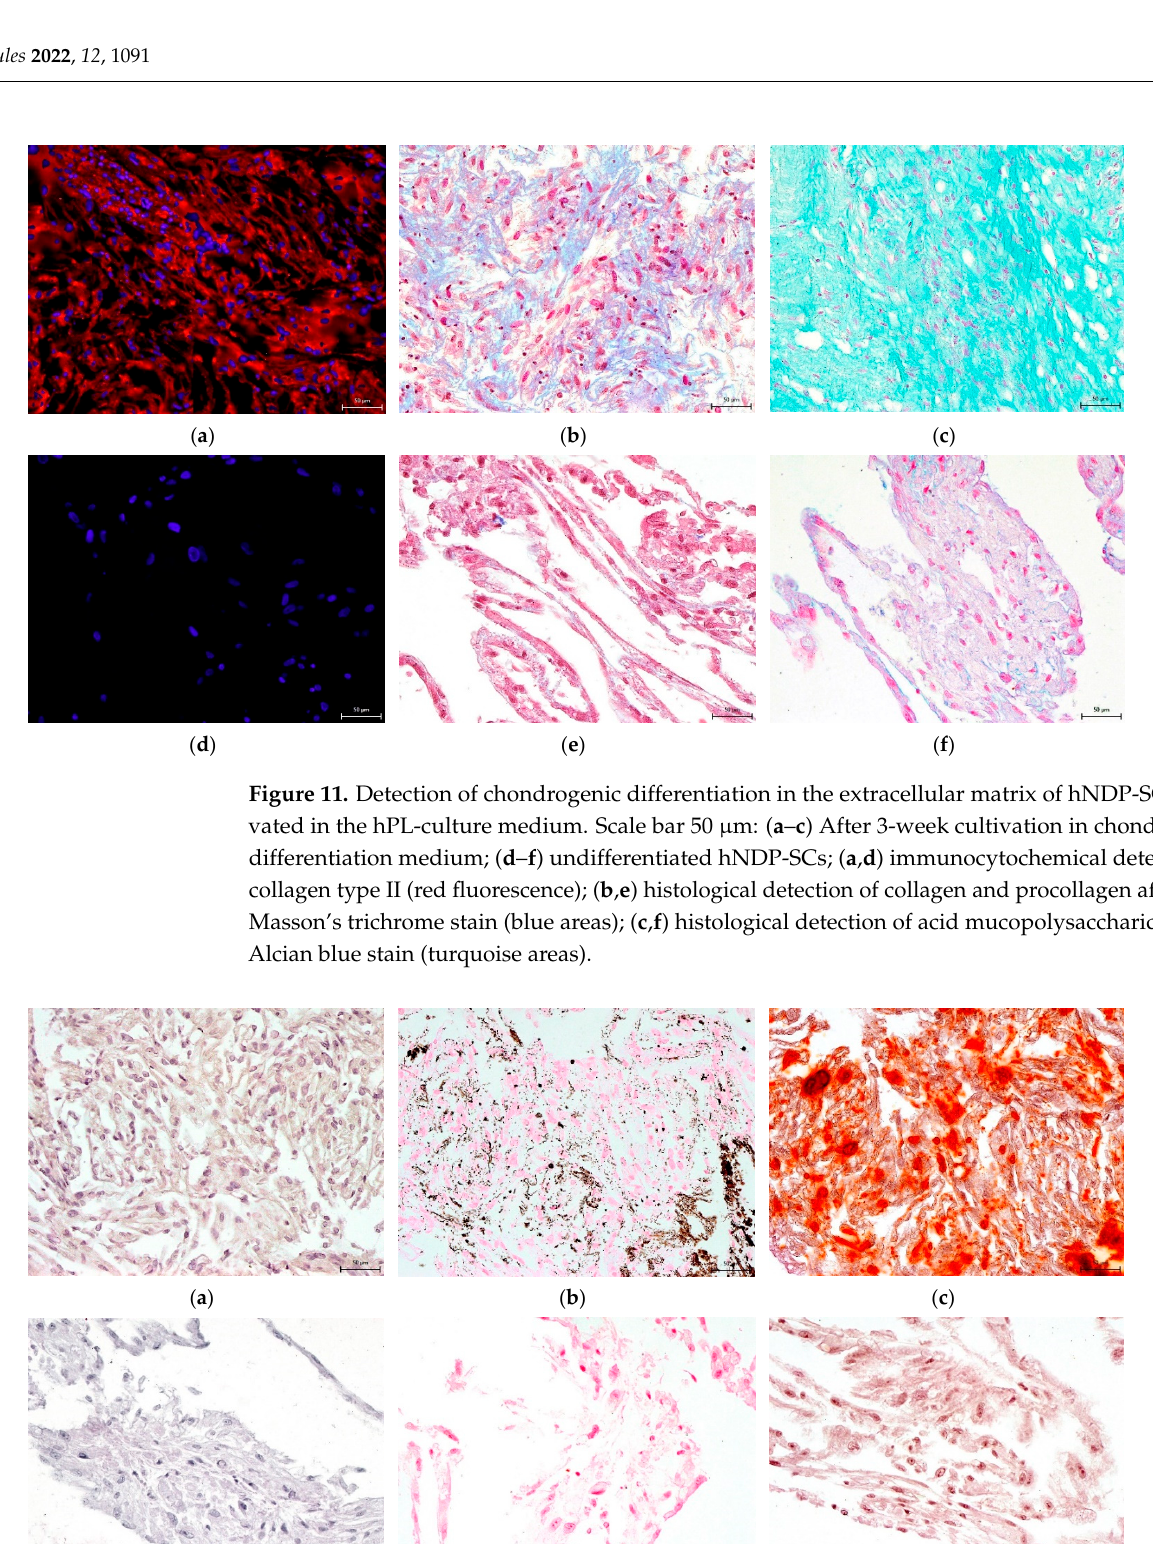
Figure 10. Detection of chondrogenic differentiation in the extracellular matrix of hNDP-SCs culti- vated in the FBS-culture medium. Scale bar 50 μ m: ( a – c ) After 3-week cultivation in chondrogenic differentiation medium; ( d – f ) undifferentiated hNDP-SCs; ( a , d ) immunocytochemical detection of collagen type II (red fluorescence); ( b , e ) histological detection of collagen and procollagen after blue Masson’s trichrome stain (blue areas); ( c , f ) histological detection of acid mucopolysaccharides after Alcian blue stain (turquoise areas).